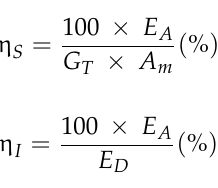
Figure 4. Point of common coupling. 4. Equipment The most important instruments for the measurement of variables of interest in the location are described as follows. •